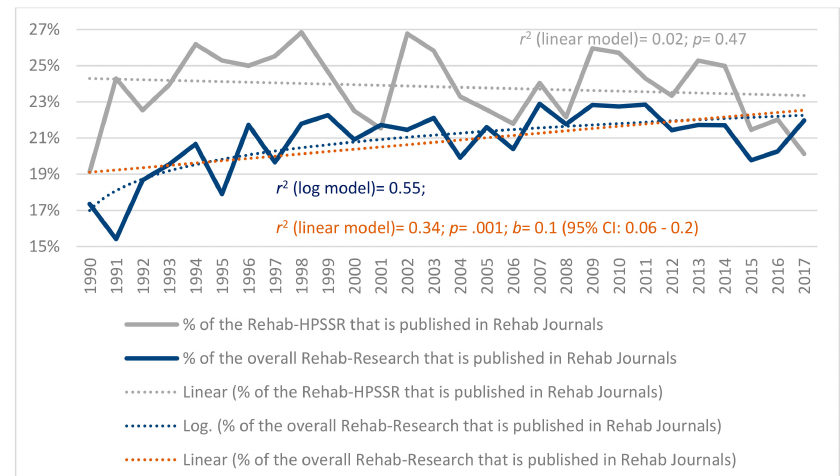
Figure 3. The yearly percentage of the rehab (i.e., rehabilitation) Health Policy, Systems and Service Research (HPSSR) and of the overall rehab research that were published in rehab journals from 1990 to 2017, and the regression models that had the best fit with the data. The p values and 95% Confidence Interval (CI) refer to the linear regression models.